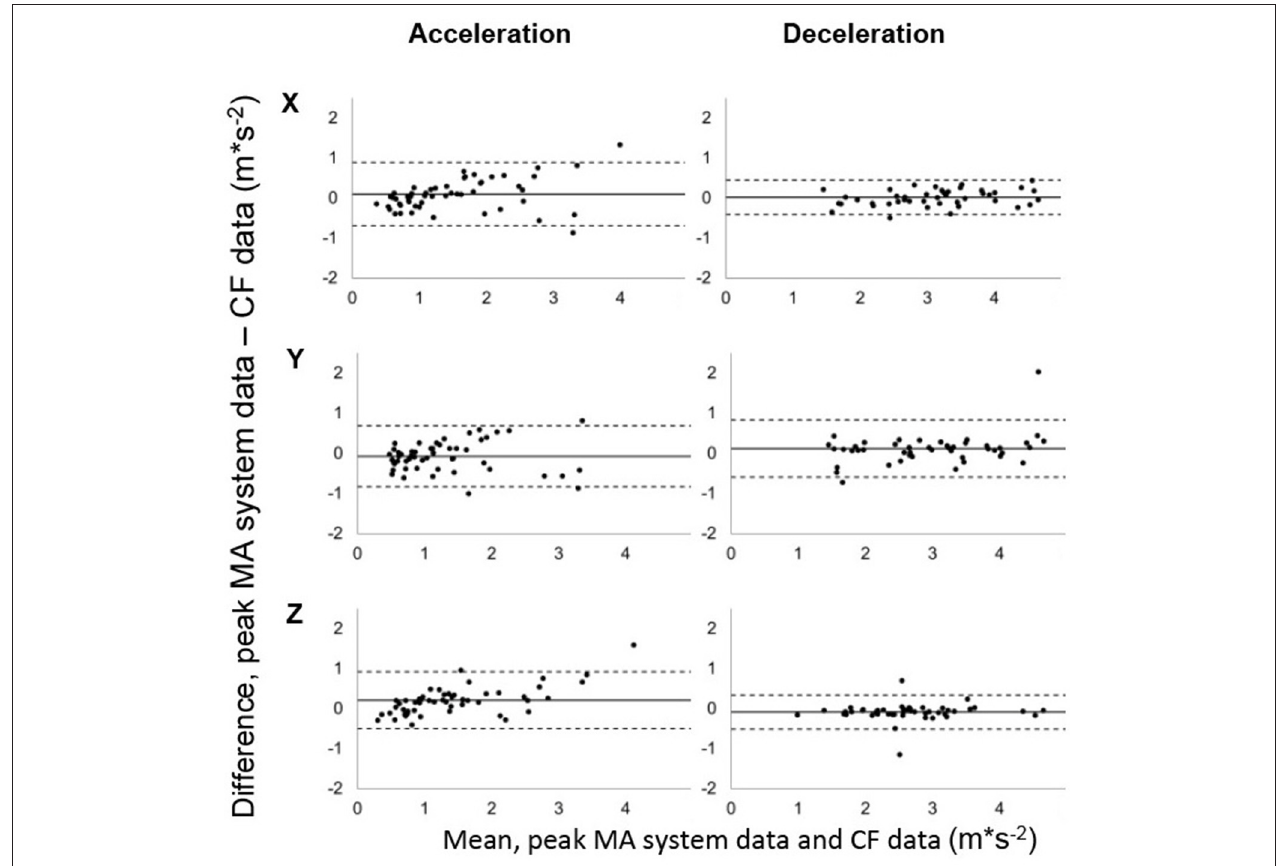
FIGURE 3 | Bland-Altman plots showing the relationship between MA system data and CF data for peak total, positive, and negative acceleration in x-, y-, and z-axis each. Dashed lines: 95% LoA, solid line: mean bias.